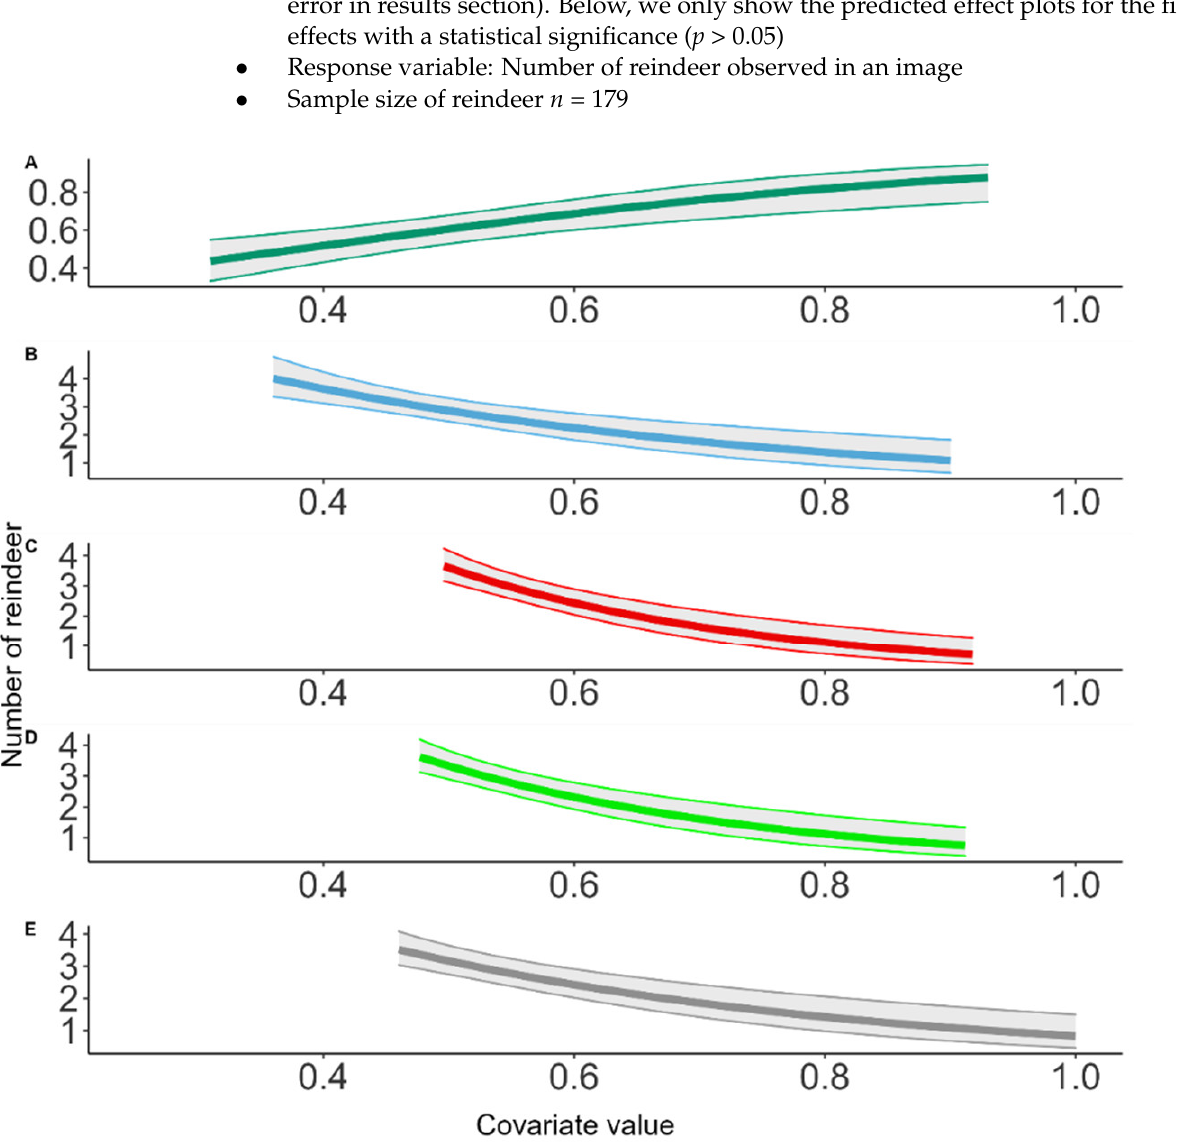
Figure A7. Predicted effects of each covariate in the five separate GLMER counts model. ( A ) greenness index, ( B ) mean blue channel, ( C ) mean red channel, ( D ) mean green channel, ( E ) median lu- minance. Table A5. Model estimates from the ten separate GLMERs for UAV P/A ( n = 234, 6 observers) and UAV count model ( n = 179, 6 observers). The coefficients are on a logit scale for the P/A models and Poisson scale for the count models. Bold denotes significant covariate effects ( p < 0.05). Random effect is reported as variance and standard deviation. Fixed Effect